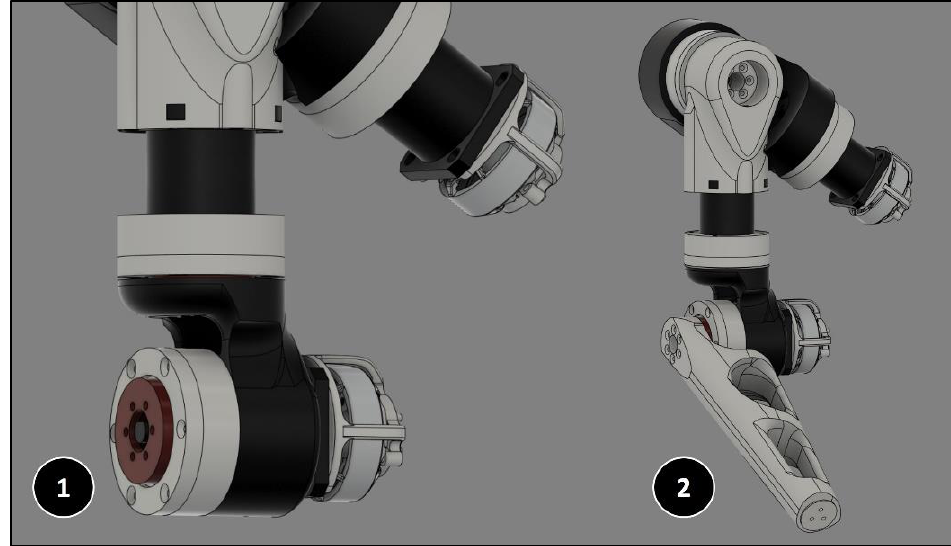
Figure 4. Design of the elbow articulation (1) and of the forearm (2)